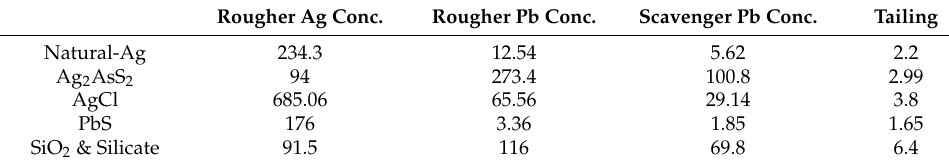
Table A2. The grade of Ag (g/t).